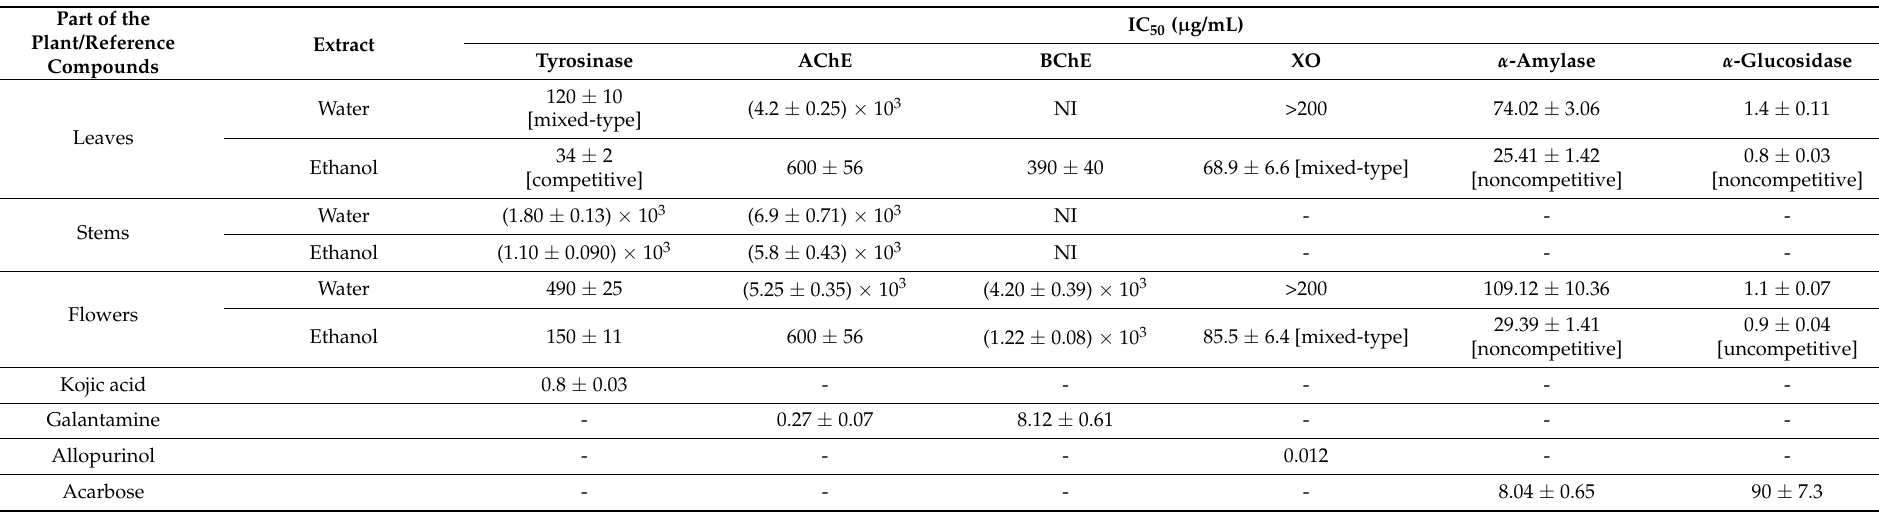
Table 5. Inhibitory activities of E. characias extracts. The inhibitory activity is expressed as IC 50 values. Kojic acid, galantamine, allopurinol and acarbose are reported as standard inhibitors. The mode of inhibition, when known, is shown in square